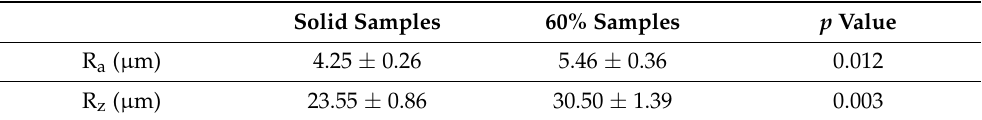
Table 3. Surface roughness measurements of solid samples were compared to 60% porous gyroid samples. Five repeat measurements of each sample were taken on the flat exterior edge and averaged. The 80% porous gyroids were excluded due to the lack of an available flat section. A student t -test was completed to determine significance between groups ( p < 0.05).